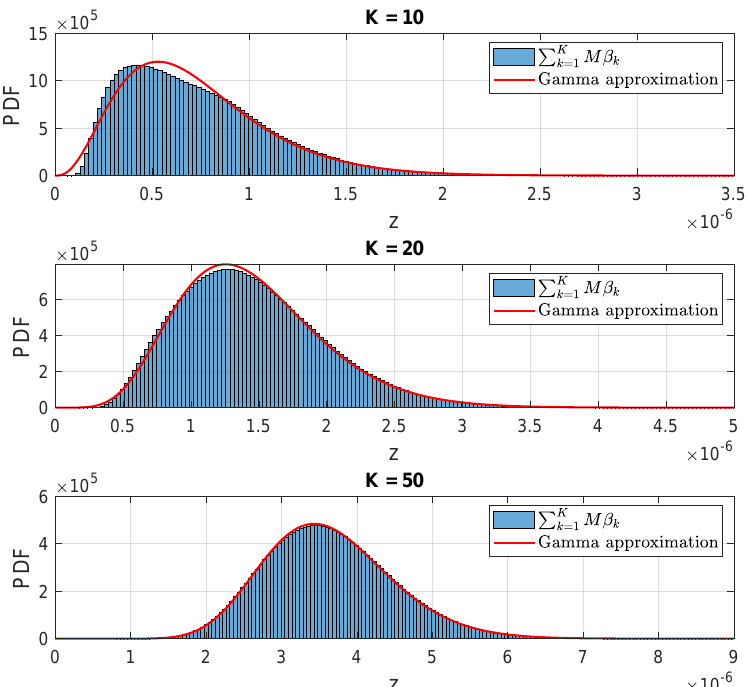
Figure 7. Gamma probability density function (PDF) for number of devices equal to K = 10, 20, and 50